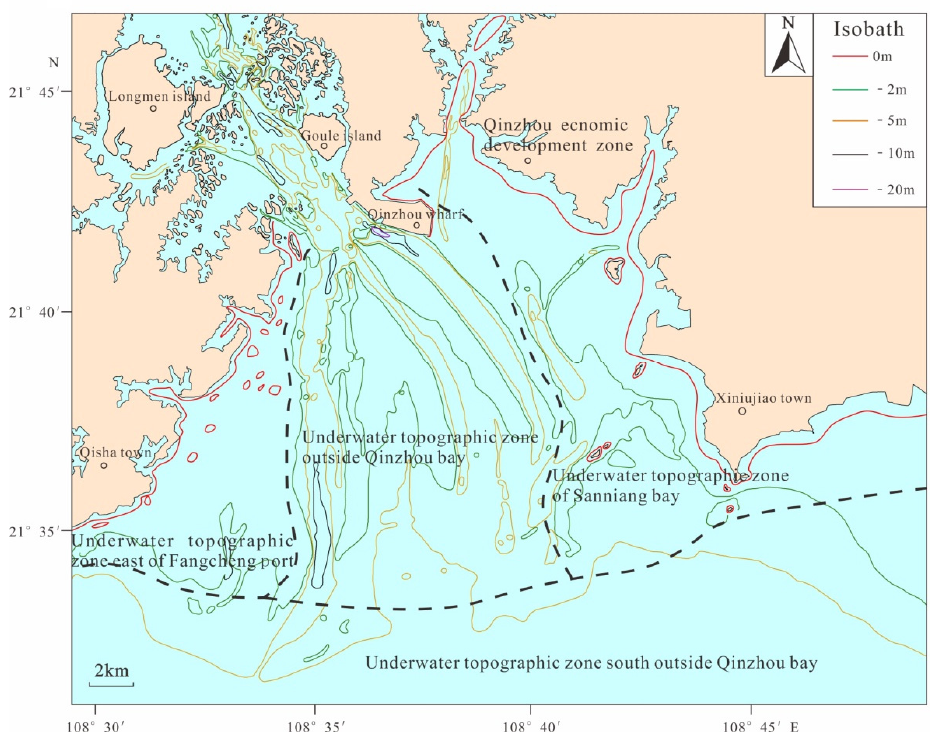
Figure 4. Submarine topography in the research area.